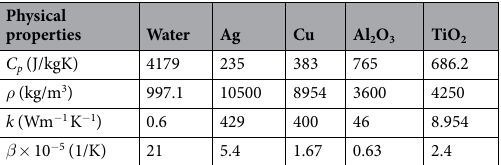
streamlines cells for all S values. The intensity of the isotherms pattern tends to be more spread out within the cavity, as shown in Figs 4(d) and 5(d). Figures 6 and 7 illustrate the effects of different values of the amplitude ratio on the streamlines and isotherms for various values of Darcy number ( Da = 10 − 5 , 10 − 4 and 10 − 3 ) for water–Cu at Ra bf = 10 5 , γ = π ϕ = 0°. The effects of constant temperature ( ε = 0) on the flow motion and the temperature profiles are presented in Figs 6(a) and 7(a). The streamlines in the enclosure show two symmetric cells at the top and bottom parts of the nanofluid layer in the enclosure. This is due to the absence of ε on the right vertical wall. We observed strong effects on the flow behavior by increasing the Darcy number, due to the buoyancy force or convection intensity